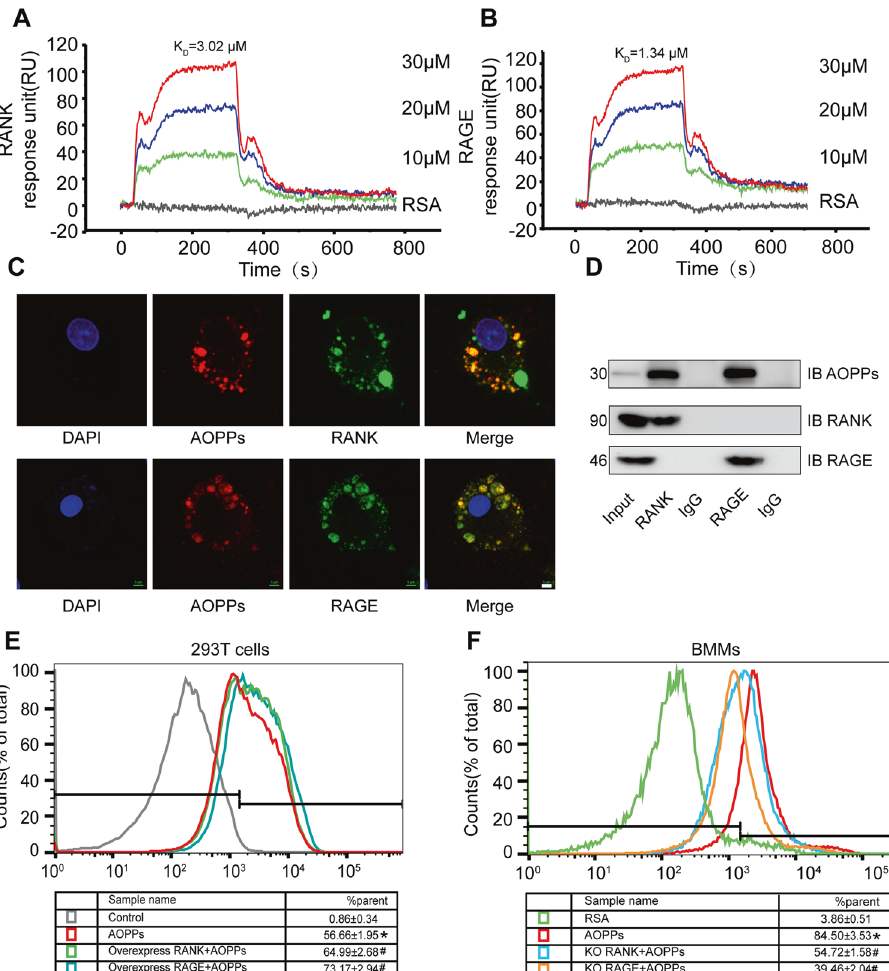
Fig. 3 Binding of AOPPs to RANK and RAGE. A , B SPR binding-af fi nity showed AOPPs bound to RANK and RAGE. C Immuno fl uorescence staining showed that TRITC-AOPPs (red) co-localized with RANK (green, up) or RAGE (green, down) on the plasma membrane of BMMs. Scale bars = 5 µm. D BMMs were treated with AOPPs. Co-immunoprecipitation (IP) analysis of AOPPs and RANK or RAGE association in BMMs. Immunoblot (IB) probed using indicated antibodies. E FACS analysis of AOPPs binding to HEK293T cells transfected with RANK or RAGE. RANK increased from 56.66 ± 1.95% (red, positive cells) to 64.99 ± 2.68% (green, RANK overexpressing cells) and 73.17 ± 2.94% (blue, RAGE overexpressing cells), and the control cell (gray) was 0.86 ± 0.34%. F In BMMs, knockdown of endogenous RANK decreased TRITC-AOPPs binding from 84.50 ± 3.53% (red) to 54.72 ± 1.58% (blue, RANK knockdown cells), and 39.46 ± 2.04% (orange, RAGE knockdown cells). * p < 0.05 versus the vehicle-treated group. # p < 0.05 versus the AOPPs-treated